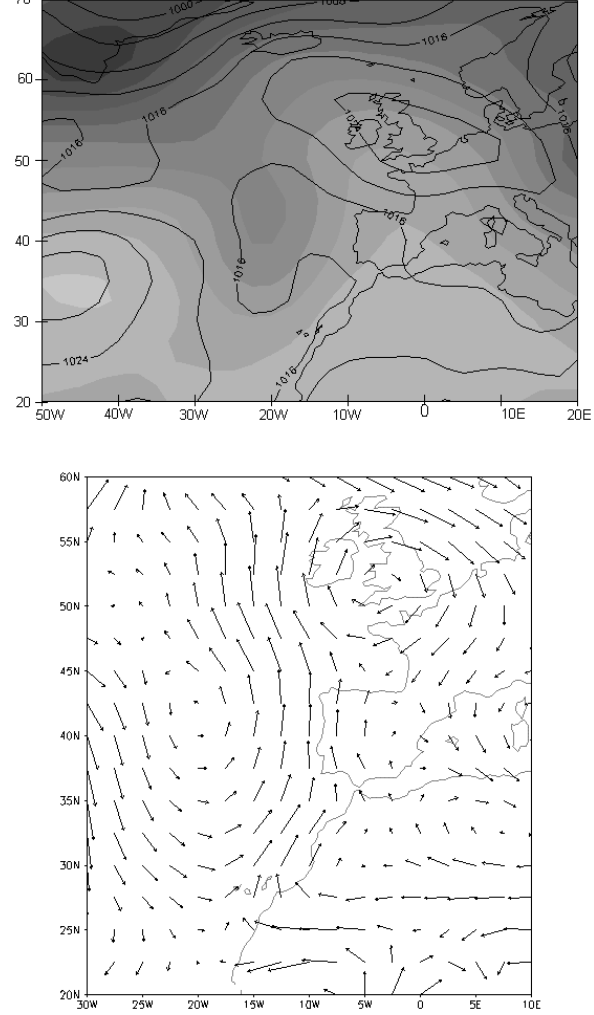
Fig. 4. (a) SLP and Z 500 field for 19 July 1989, corresponding to a selected southern flux situation. (b) Similar to (a) , but for the wind at